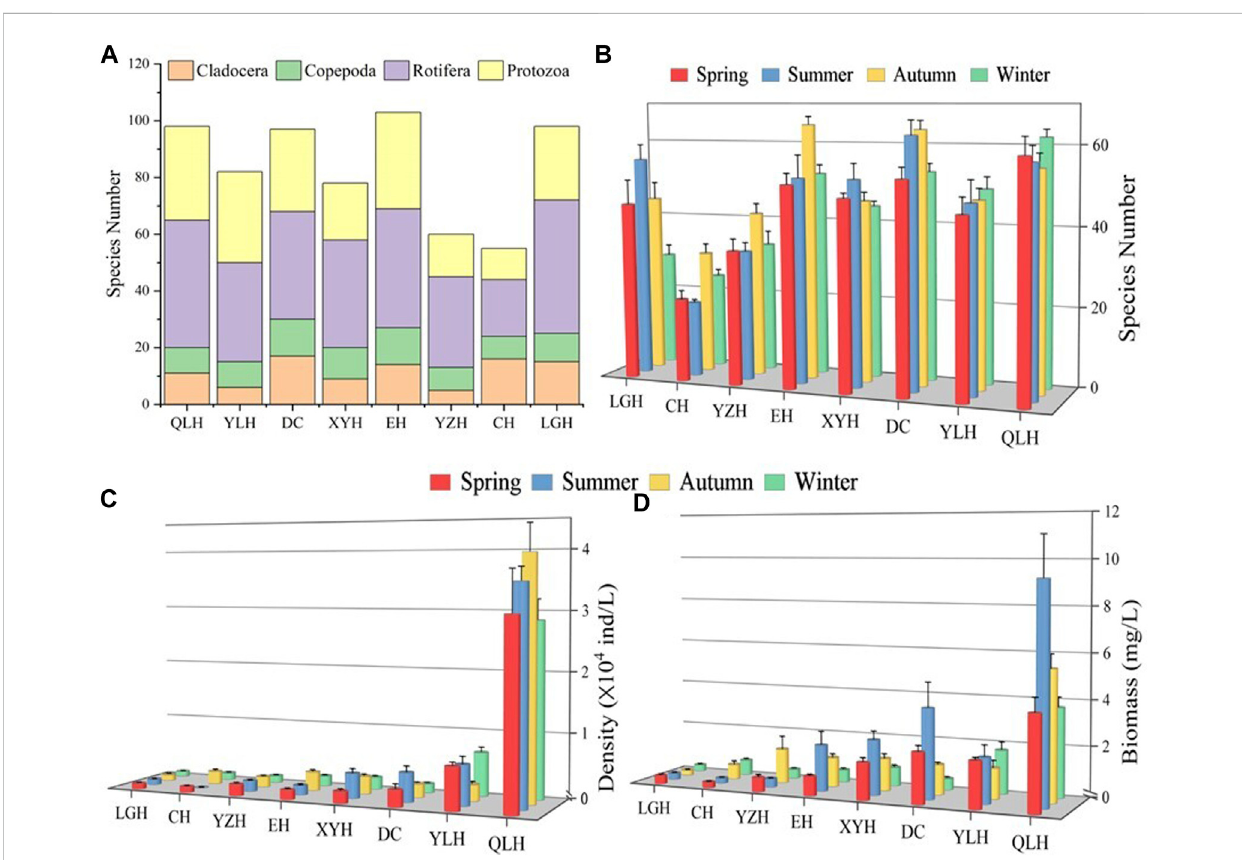
FIGURE 2 Zooplankton assemblagecompositionintheeightstudiedlakes. (A) Species numberoftheeightmajor taxa, (B) speciesnumberinthefourseasons. Density (C) and biomass (D) of the main zooplankton groups. Explanation of the abbreviated lake names is given in Figure